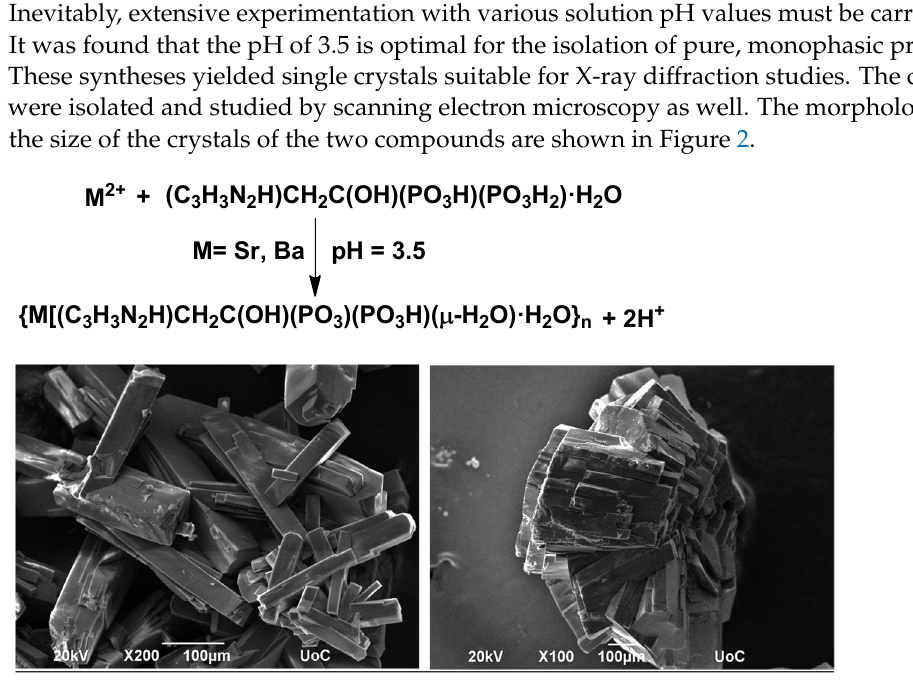
Figure 2. Reaction scheme for the synthesis of (Sr/Ba)–ZOL (upper) and SEM images of single crystals of Sr–ZOL (lower left) and Ba–ZOL (lower right).